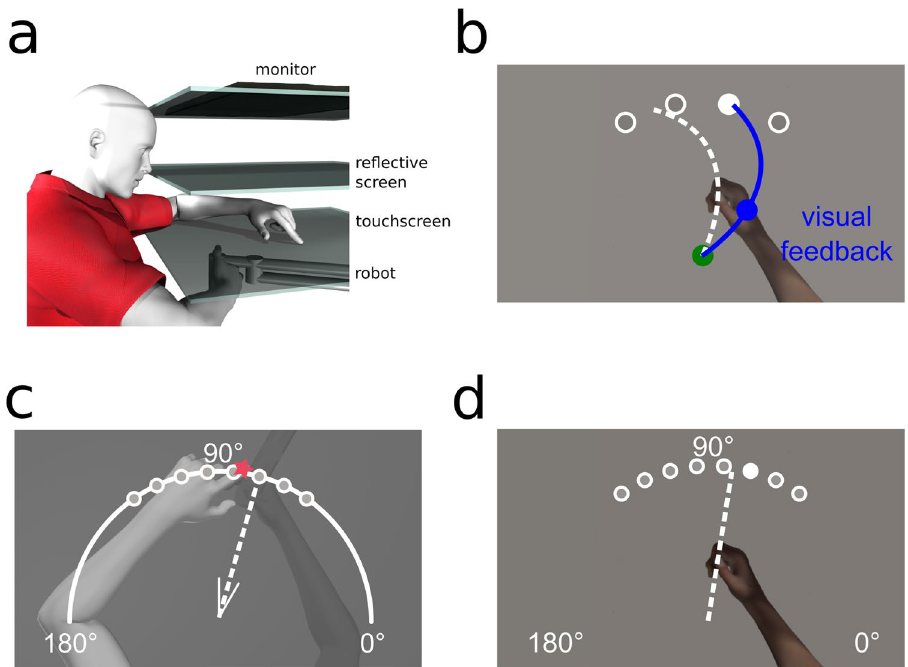
Figure 5. Experimental setup and design. ( a ) Side view of the experimental set-up. The top layer is the monitor, middle layer is the reflective screen, and the bottom opaque layer is the touchscreen. The robot is depicted beneath with the participants’ right hand grasping it. ( b–d ) Top views of task specific set-ups. ( b ) Training (and Clamp) trial. The home position is represented by a green circle with a 1 cm diameter; located approximately 20 cm in front of the subject . Targets are represented by white circles with a 1 cm diameter located 12 cm radially from the home position at 60°, 80°, 100° and 120°. Participants hand cursor was also a 1 cm diameter blue circle. ( c ) Localization test trial. Participants were either passively moved to one of the eight target locations, or actively moved their hand in the direction suggested by the white wedge, consisting of two short straight lines (V-shaped) at the home position, these real and suggested locations are 55°, 65°, 75°, 85°, 95°, 105°, 115° and 125°. Subsequently, participants used a touch screen to indicate on a white arc spanning 180° where their unseen right hand was. ( d ) No-cursor test trial. Participants made ballistic reaches to one of the 8 target locations also used in localization without any visual feedback of their movement. Figures were made using Poser Rendering Software version 11, https:// www. poser softw are. com/.